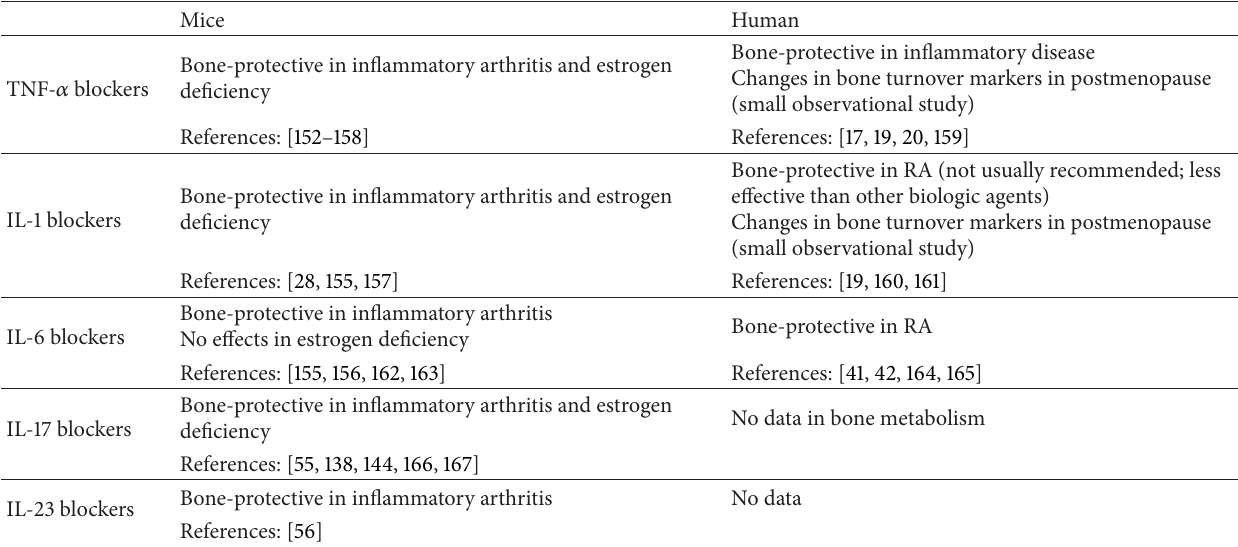
Table 2: Effects of biologic therapies on